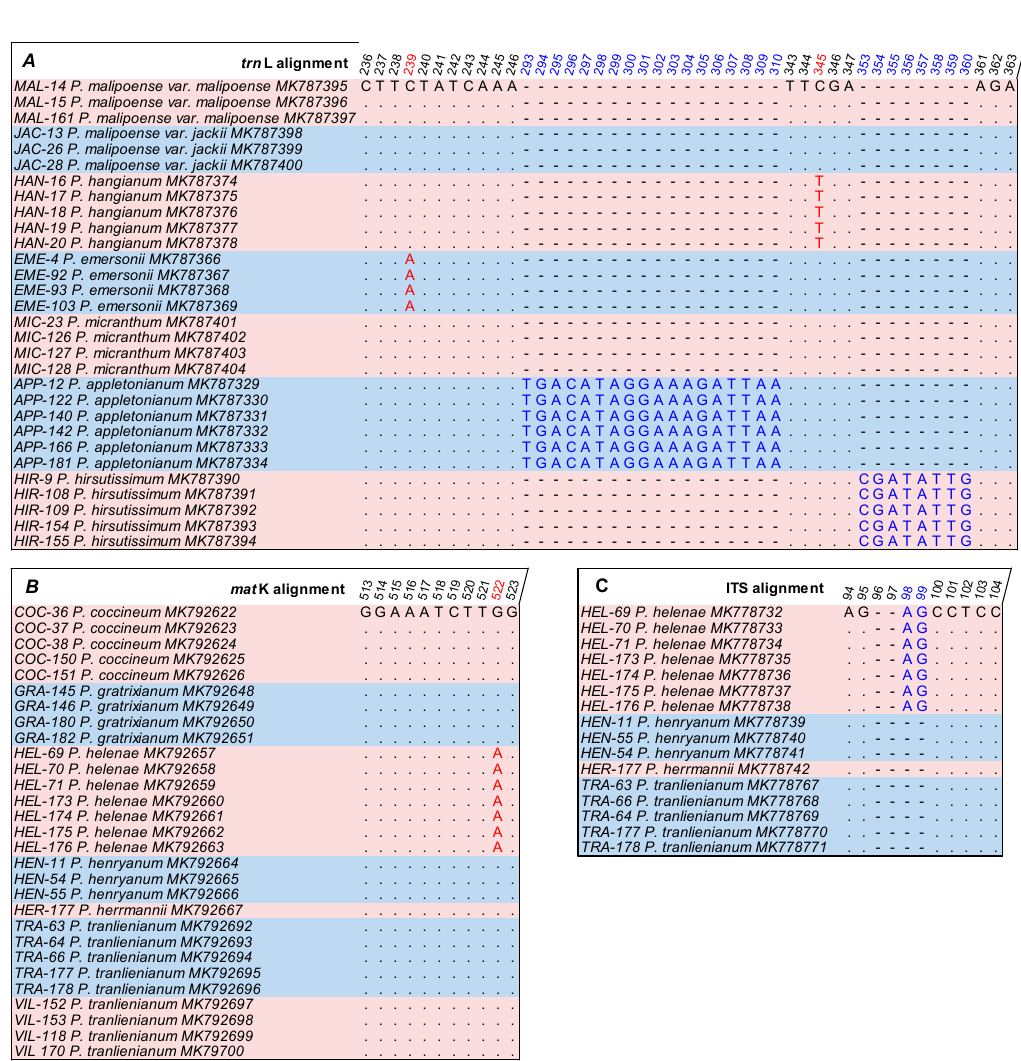
Figure 2. Informative variable sites from DNA alignment data of eight Vietnamese Paphiopedilum sequences on ITS, mat K, and trn L alignments using the MEGA software. ( A ): trn L alignment; ( B ): mat K alignment; ( C ): ITS alignment. (Number on top lines: alignment site; dot: nucleotide that is identical to one of the sequences at the first line; dash: gap; red color: site of nucleotide substitution; blue color: site of insertion fragment; fill color: was used to clarify the distinction between the sequences of the same species).